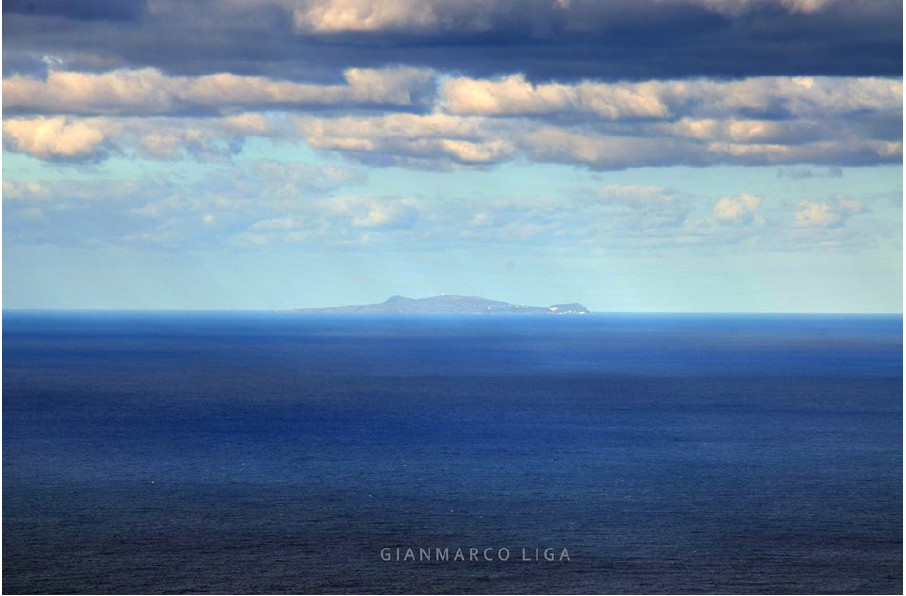
Figure 1 . The island of Ustica as seen from the coast of Palermo on a clear day (courtesy of G.